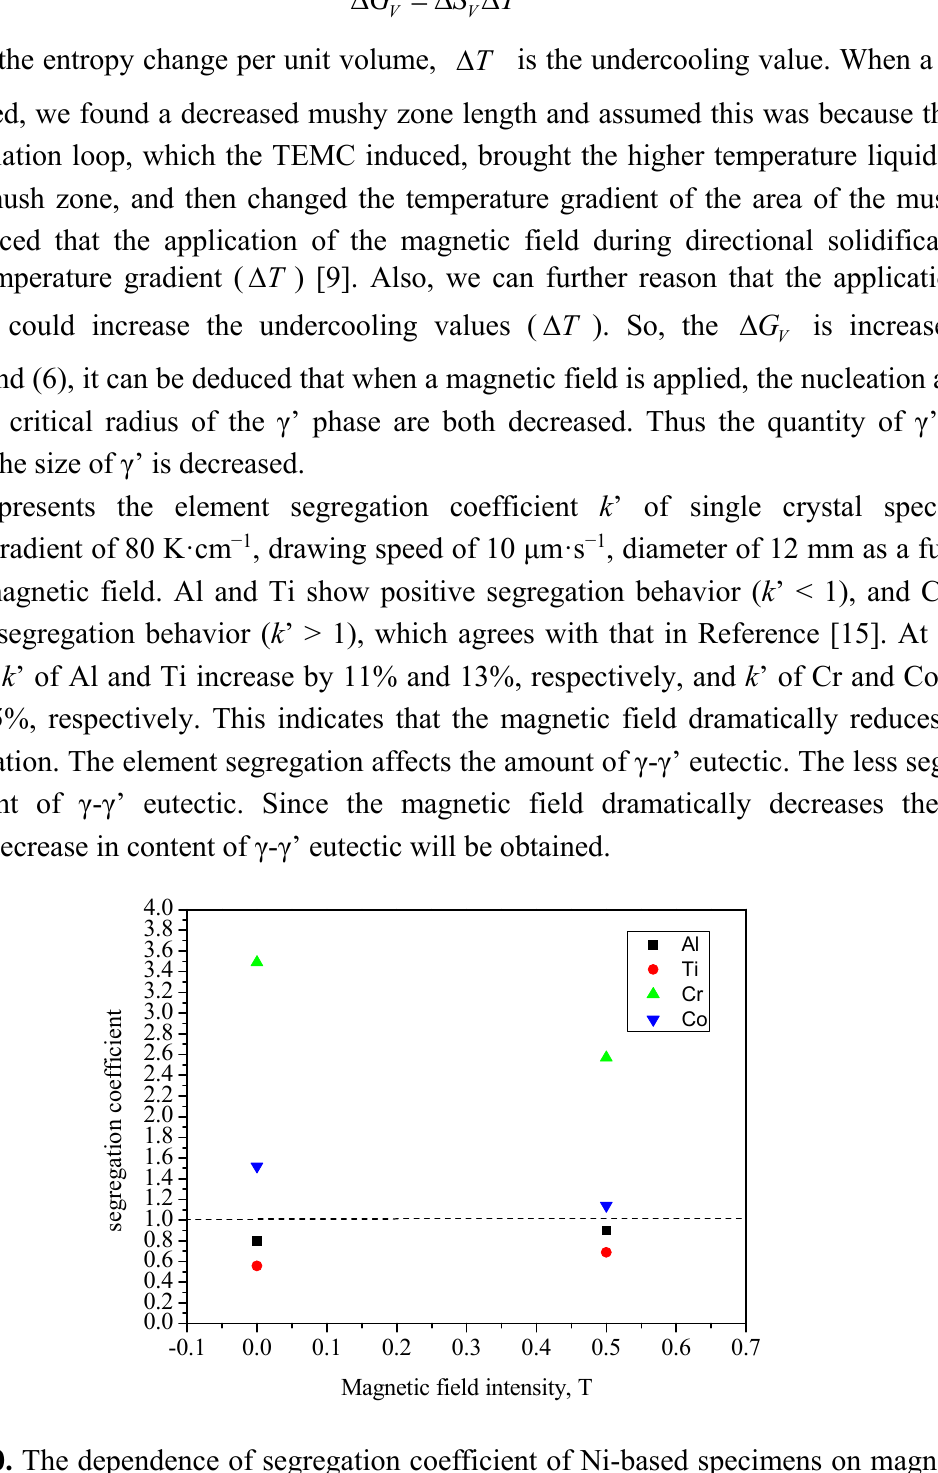
Figure 10. The dependence of segregation coefficient of Ni-based specimens on magnetic field at a temperature gradient of 80 K·cm − 1 , drawing speed of 10 μ m·s − 1 , diameter of 12